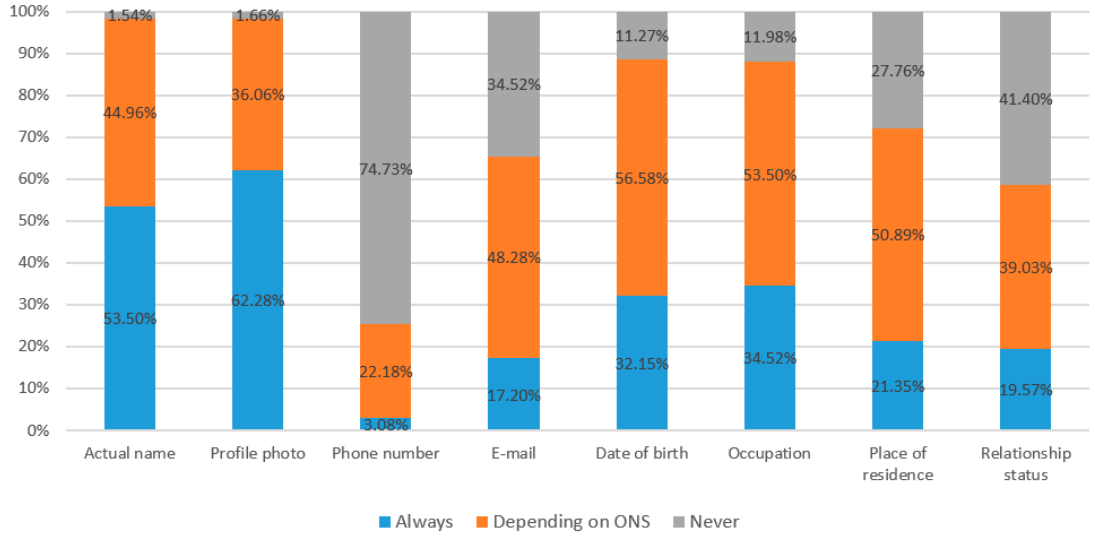
Figure 2. Personal data sharing.